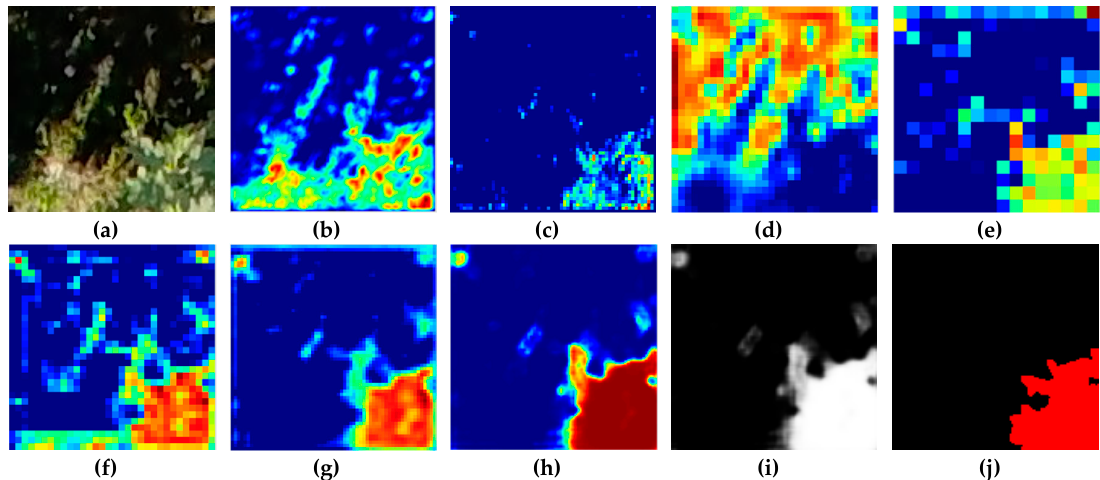
Figure 7. Visualization of the activations of our network: ( a ) input image. The output maps of the encoder part from: ( b ) the 128 × 128 convolutional+ReLU layer; ( c ) the 64 × 64 convolutional+ReLU layer; ( d ) the 32 × 32 convolutional+ReLU layer; and ( e ) the 16 × 16 convolutional+ReLU layer. The output maps of the decoder: ( f ) the 32 × 32 convolutional+ReLU layer; (g) the 64 × 64 convolutional+ReLU layer; ( h ) the 128 × 128 convolutional+Sigmoid layer; and ( i ) the output and ( j ) GT image.